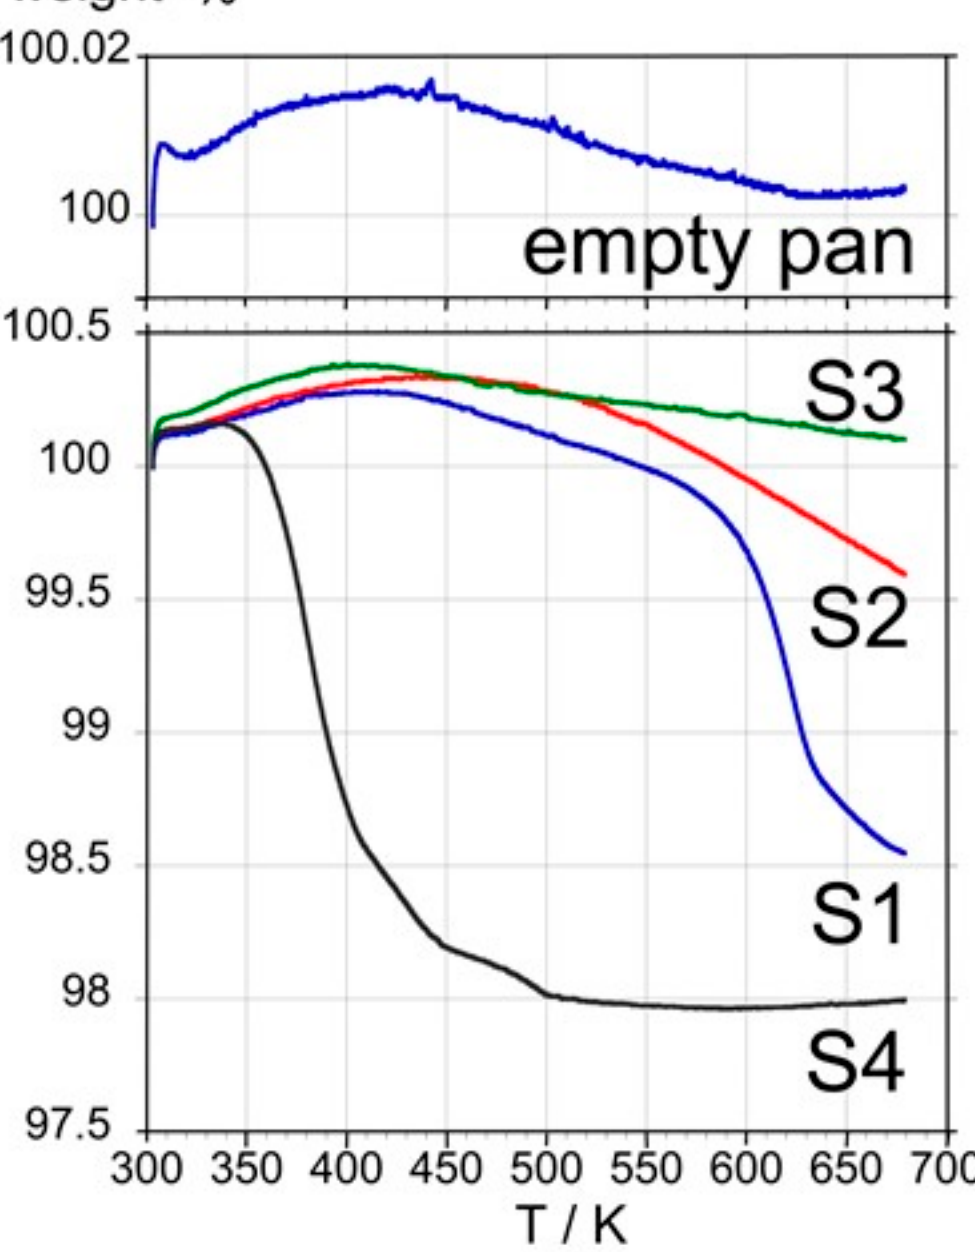
Figure 4. Thermogravimetric curves obtained with samples S1, S2, S3, S4, and an empty pan at a heating rate of 10 K min − 1 .